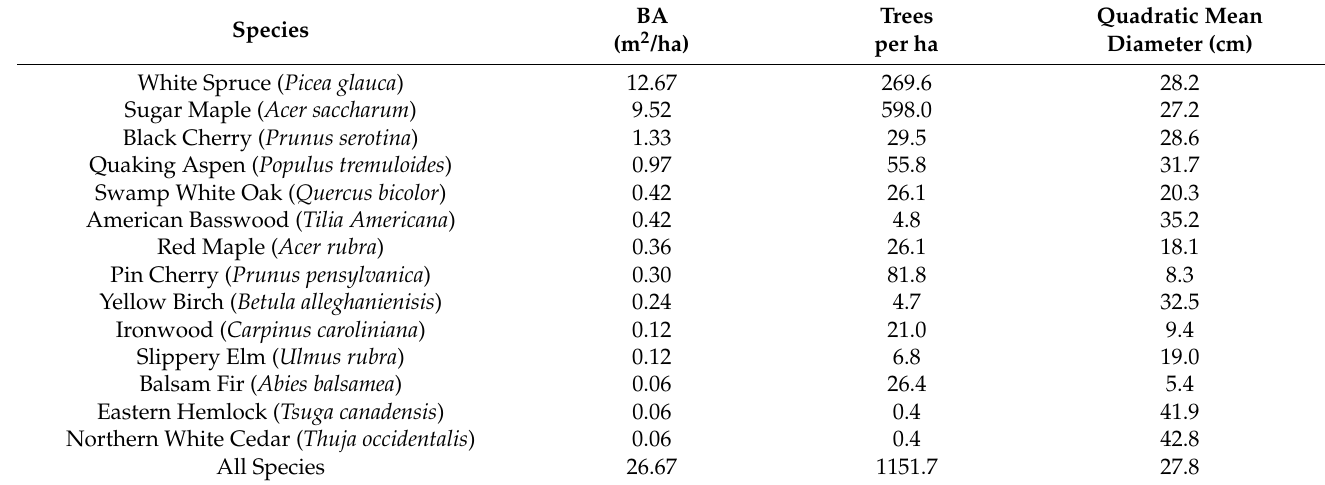
Table 1. Stand composition data, including basal area, trees per hectare, and quadratic mean